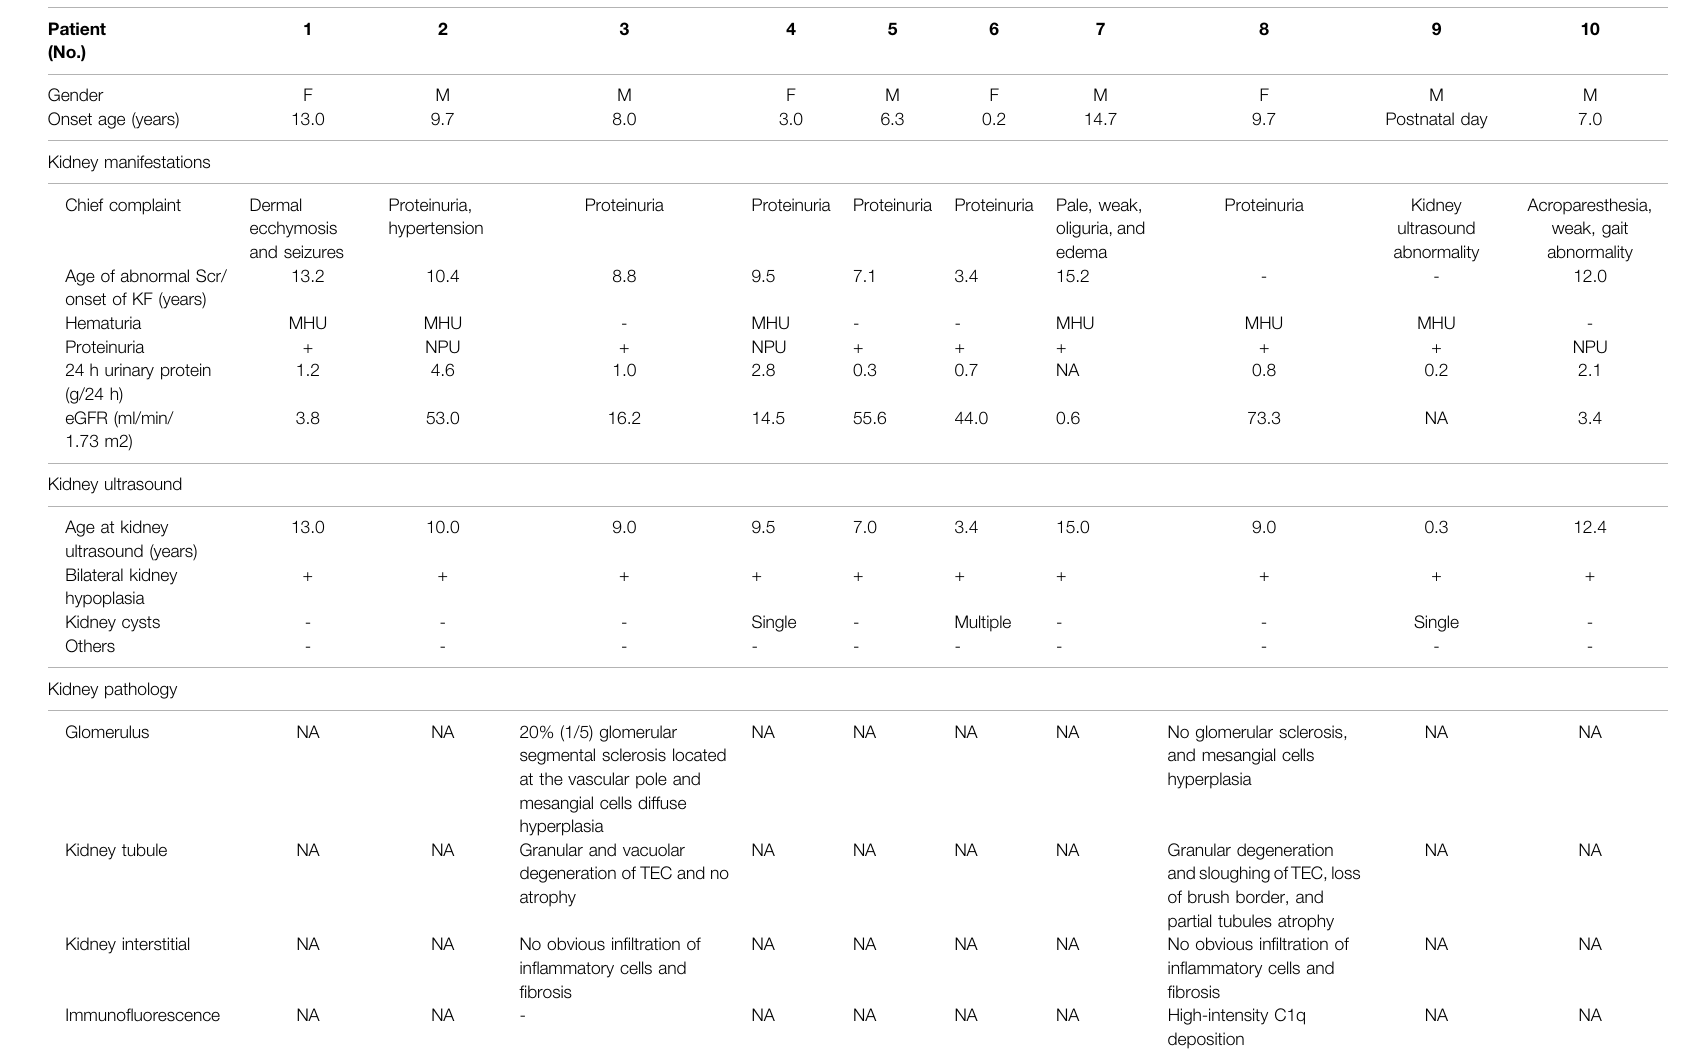
TABLE 1 | Kidney phenotypes of patients with variants in PAX2 . Patient